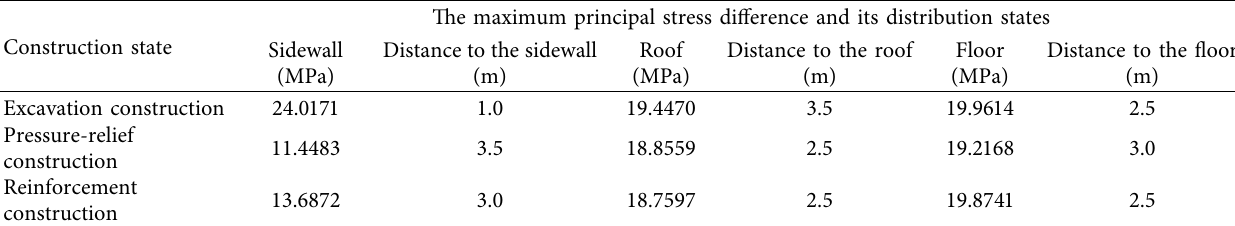
Table 2: Maximum principal stress difference of roadway surrounding